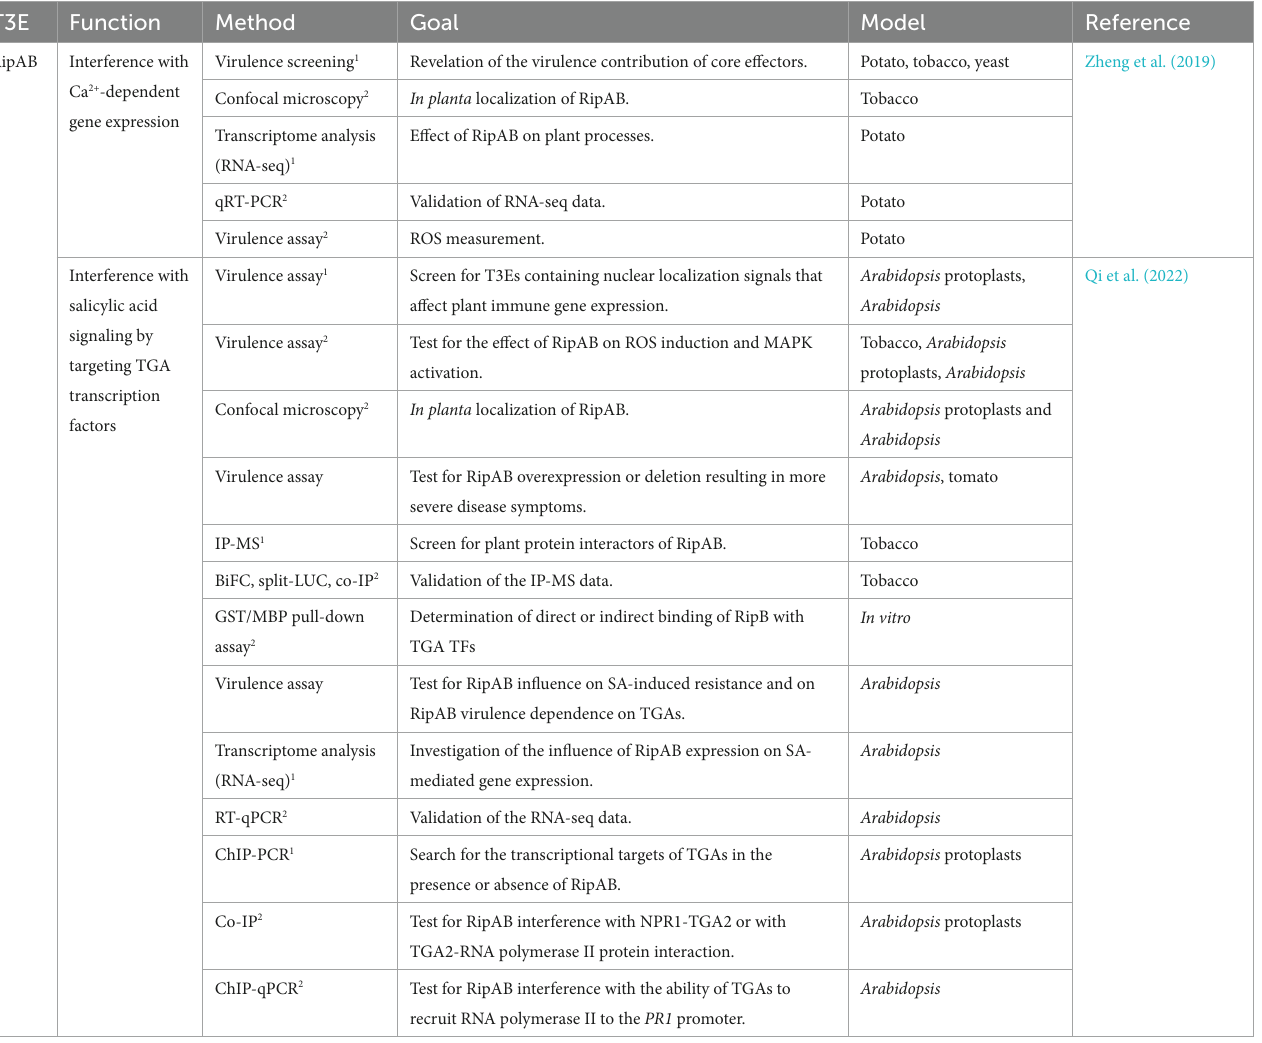
TABLE 3 Methods used to characterize RipAB and its putative function.